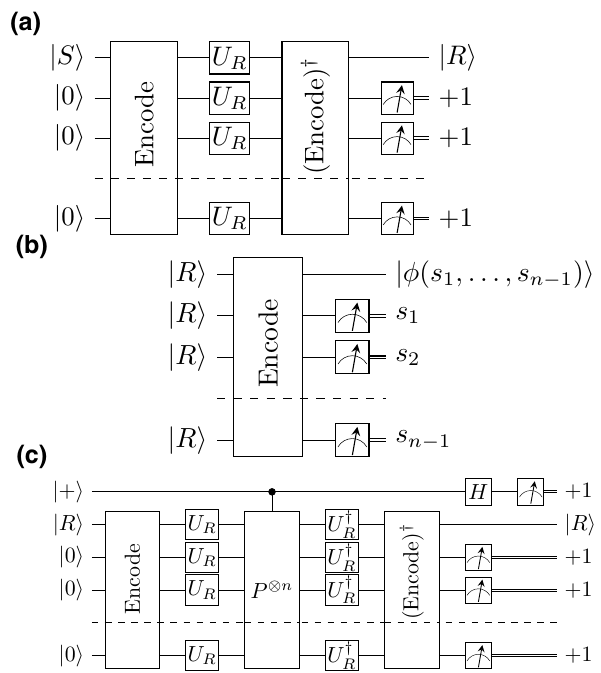
FIG. 7. The three known types of state-distillation schemes for a resource state | R (cid:2) . Each wire represents a logical qubit of a QEC scheme that fault tolerantly performs all Clifford gates. (a) We need a code with a transversal non-Clifford gate U R , such that U R | S (cid:2) = | R (cid:2) for some stabilizer state | S (cid:2) . (b) We need a code with a transversal gate C R , such that C R | R (cid:2) = | R (cid:2) . The measure- ment of the stabilizers of the code will be probabilistic even when | R (cid:2) input is noiseless, with postselected state | φ( + 1, . . . , + 1 ) (cid:2) = | R (cid:2) . (c) We need a code with a transversal gate C R , such that C R | R (cid:2) = | R (cid:2) and C R = U R PU R † for some Pauli operator P